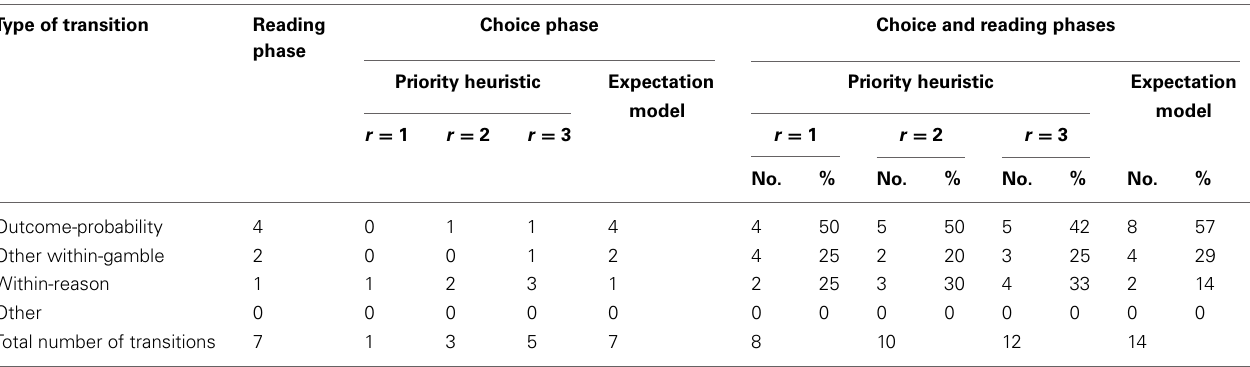
Table A2 | Derivation of the predicted transitions (cf. Brandstätter et al., 2008).